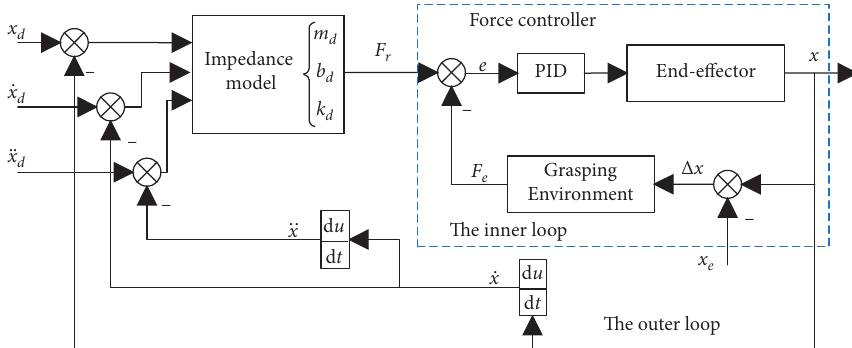
Figure 8: Diagram of the force-based impedance control system.